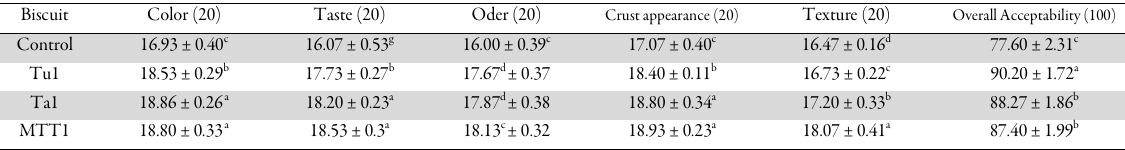
Table 12. Sensory evaluation of colored barley flour biscuits using different levels of turmeric and tartrazine powder Biscuit Color (20)